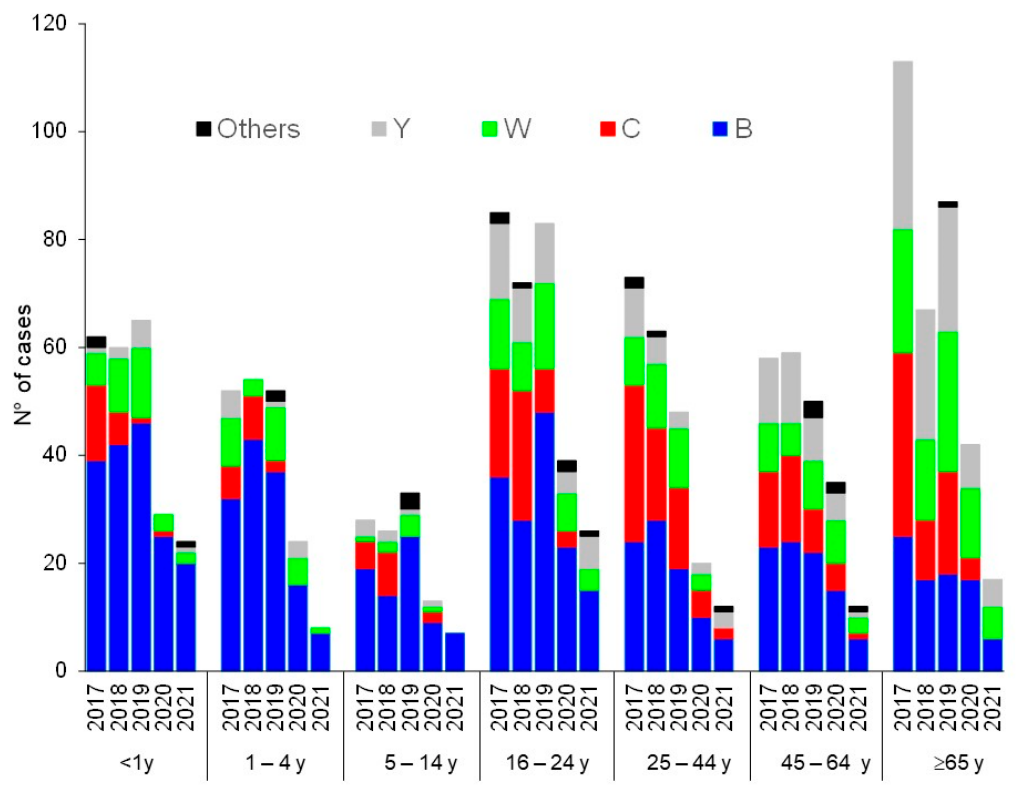
Figure 2. Evolution of number of cases of IMD over the period 2017–2021 per age group and per serogroup.